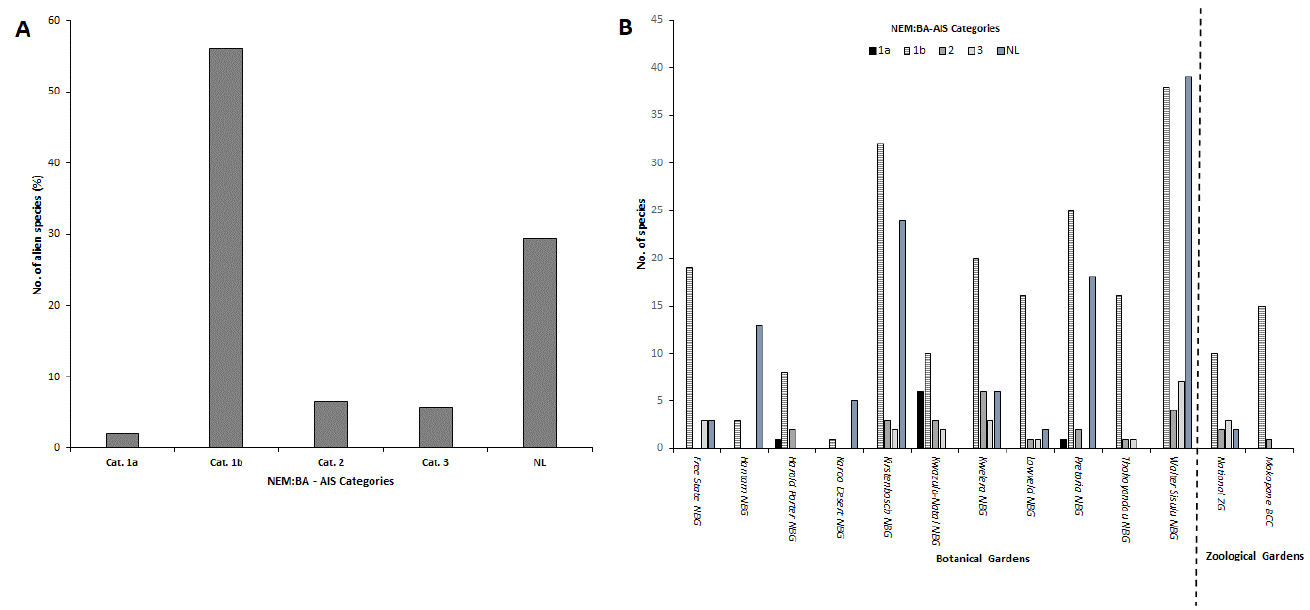
Figure 5. Numbers of alien species’ records (%; n = 380) in different NEM:BA-AIS Regulations’ categories for species ( A ) and their occurrence in different SANBI Gardens ( B ). Cat. = Category. Category 1a: Species that are targets for eradication. Category 1b: Species that are control targets and need a national management plan. Category 2: Species requiring a permit for restricted activities. Category 3: Species that are subject to exemptions. “Not Listed” (NL): Unlisted species: alien species